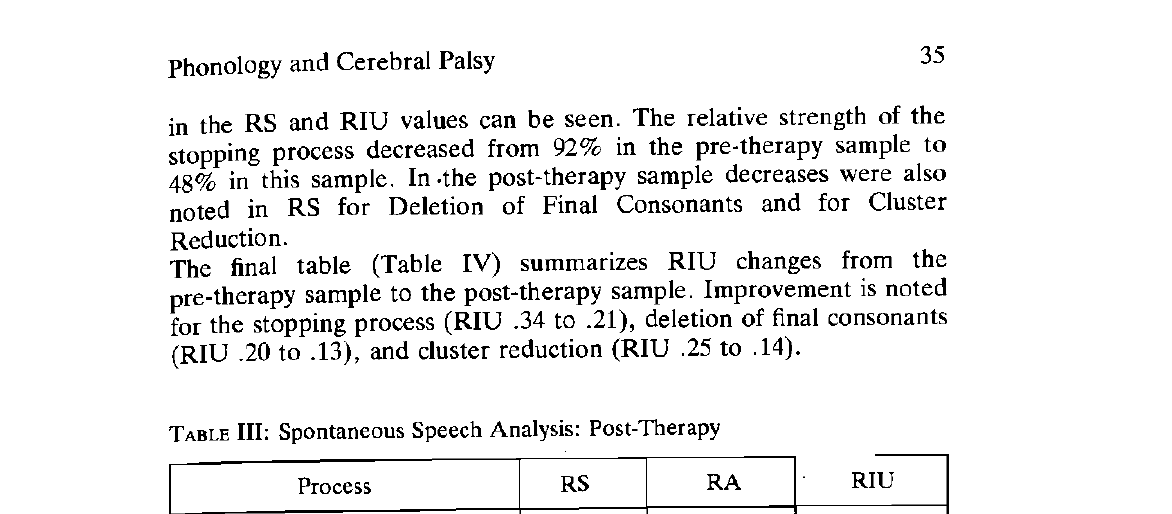
TABLE III: Spontaneous Speech Analysis: Post-Therapy Process RS RA RIU Deletion Final Con. .18 .74 .13 Cluster Reduction .80 .17 .14 Prevocalic Voicing .52 .28 .14 Stopping .48 .44